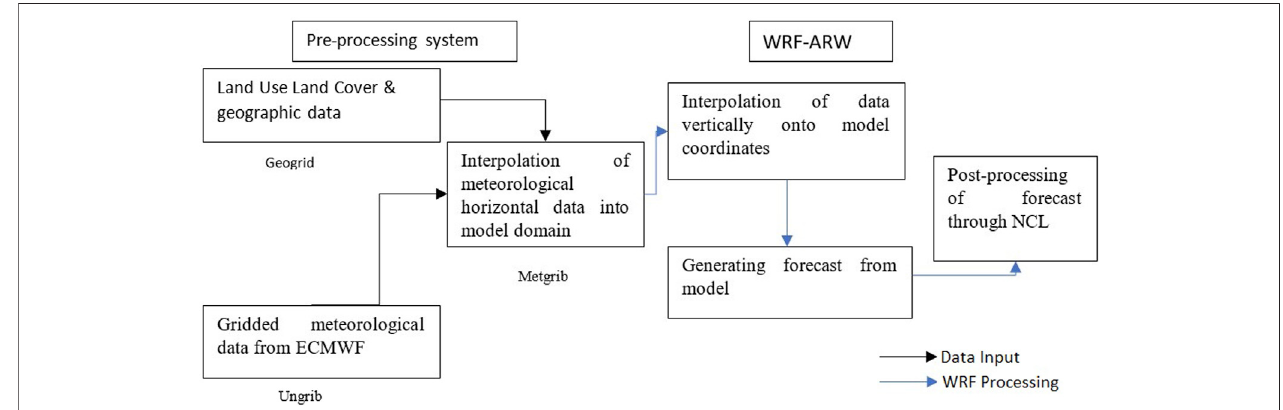
FIGURE 1 | Work fl ow of the WRF model. The model consists of two sections, namely, the WRF pre-processing system (WPS) and WRF-ARW section.